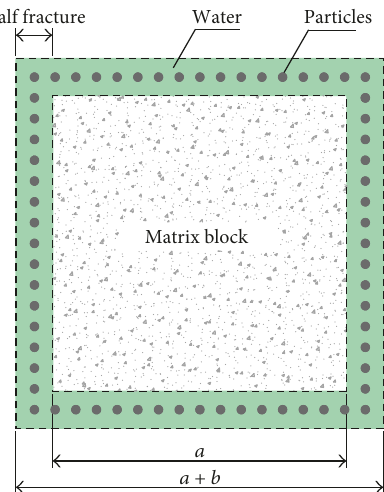
Figure 5: Sketch of a representative element of a typical